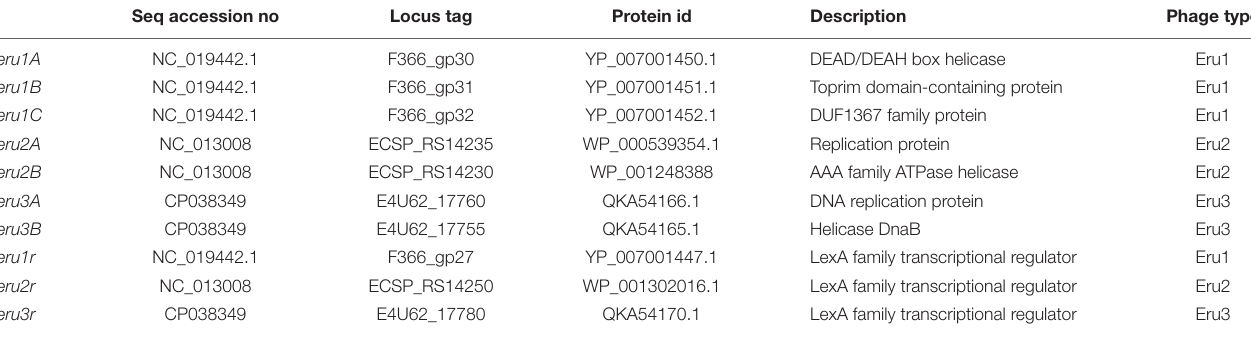
TABLE 1 | Description of genes belonging to the three different Eru type